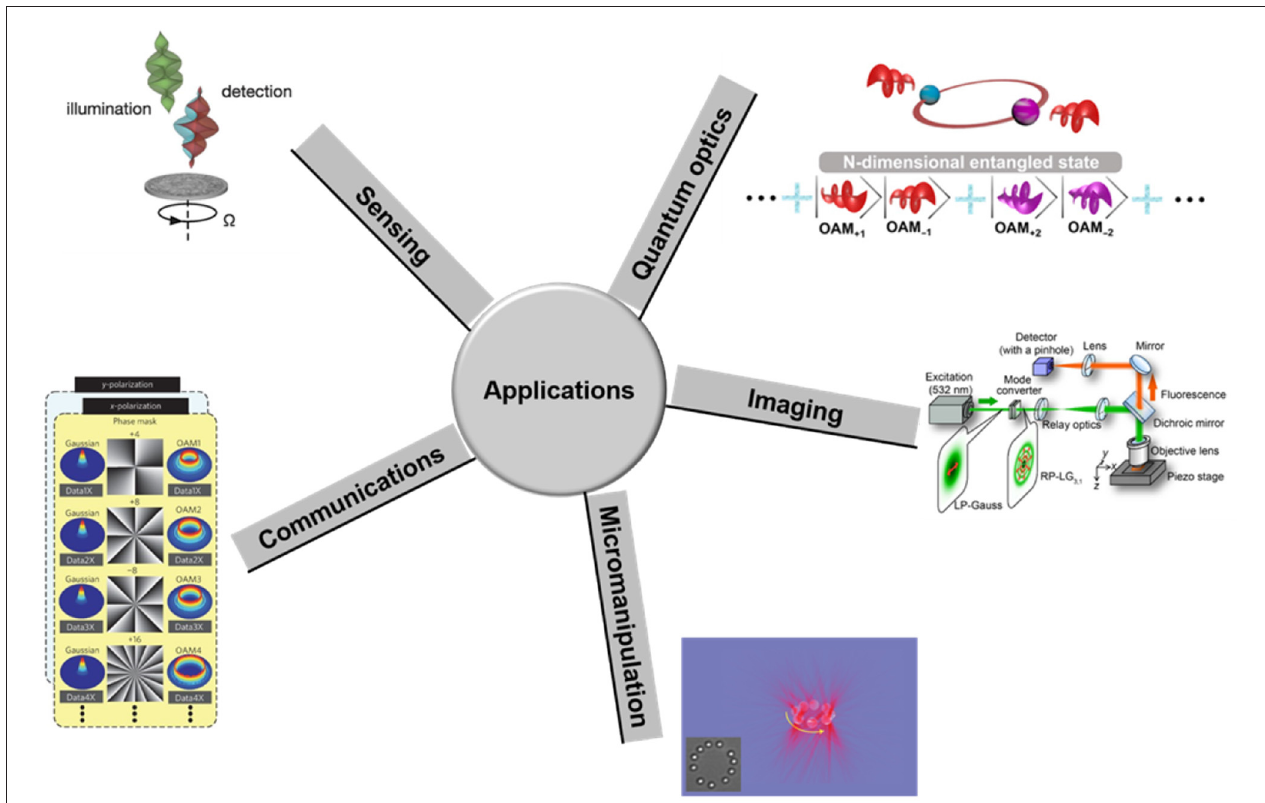
FIGURE 12 | Diverse applications of structured light beams. Reprinted from Wang et al. [1], Lavery et al. [4], Padgett and Bowman [6], Liu et al. [8], and Kozawa et al. [ 9].